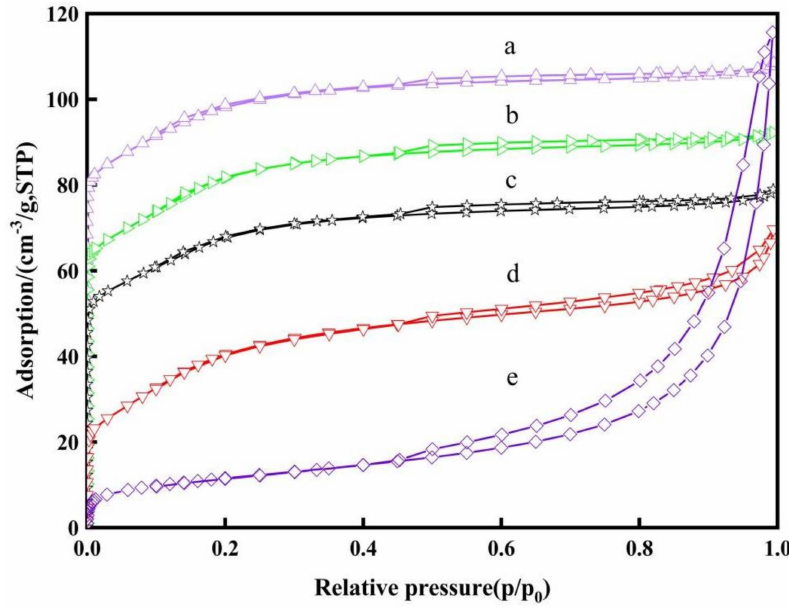
Figure 6. N 2 adsorption-desorption isotherms of pure ZSM-5 ( a ) and composite products with different Zn/Si ratios Zn–ZSM-5 n(Zn)/n(Si) of: ( b ) 1:200; ( c ) 1:100; ( d ) 1:50; ( e )